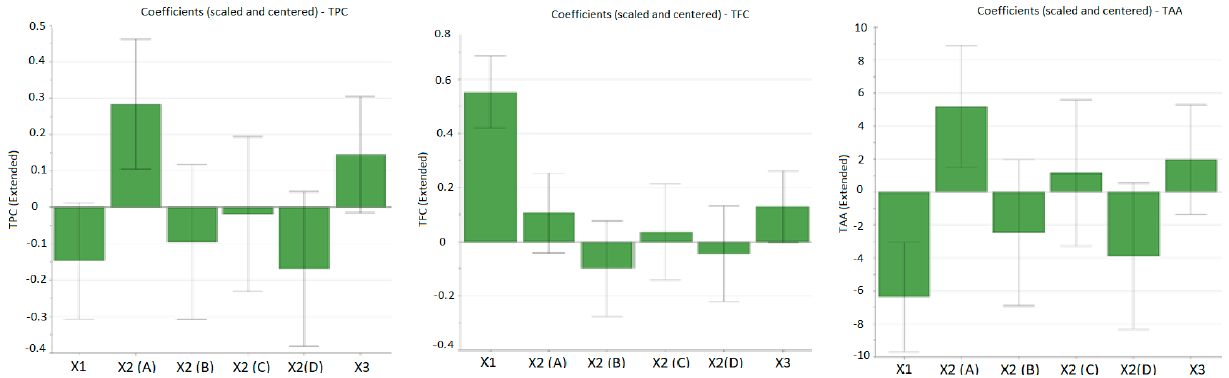
Figure 1. The influence of working conditions on TPC (total phenolic content), TFC (total flavonoid content), and TAA (total antioxidant activity) by TEAC assay upon E. hirsutum leaves extracts dur-